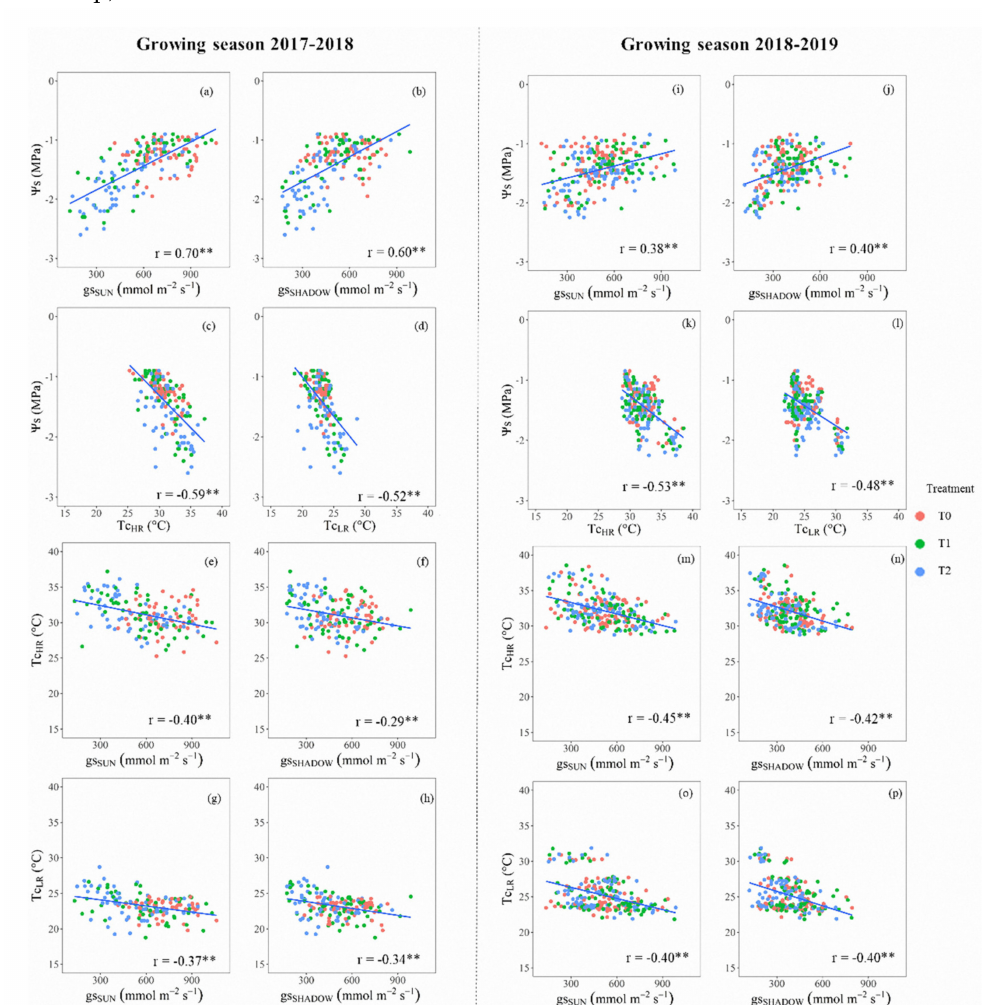
Figure 3. Linear relationships among average values of midday stem water potential ( Ψ s), stomatal conductance(gs)forsunlit(SUN)andshaded(SHADOW)leaves, andcanopytemperature(Tc)forcherry trees ‘Regina’ for each post-harvest irrigation treatment (control: T0 ( Ψ s ≥ − 1.0 MPa); low–medium water stress: T1 ( − 1.0 ≥ Ψ s ≥ − 1.5 MPa), and high (severe) water stress: T2 ( − 1.5 ≥ Ψ s ≥ − 2.0